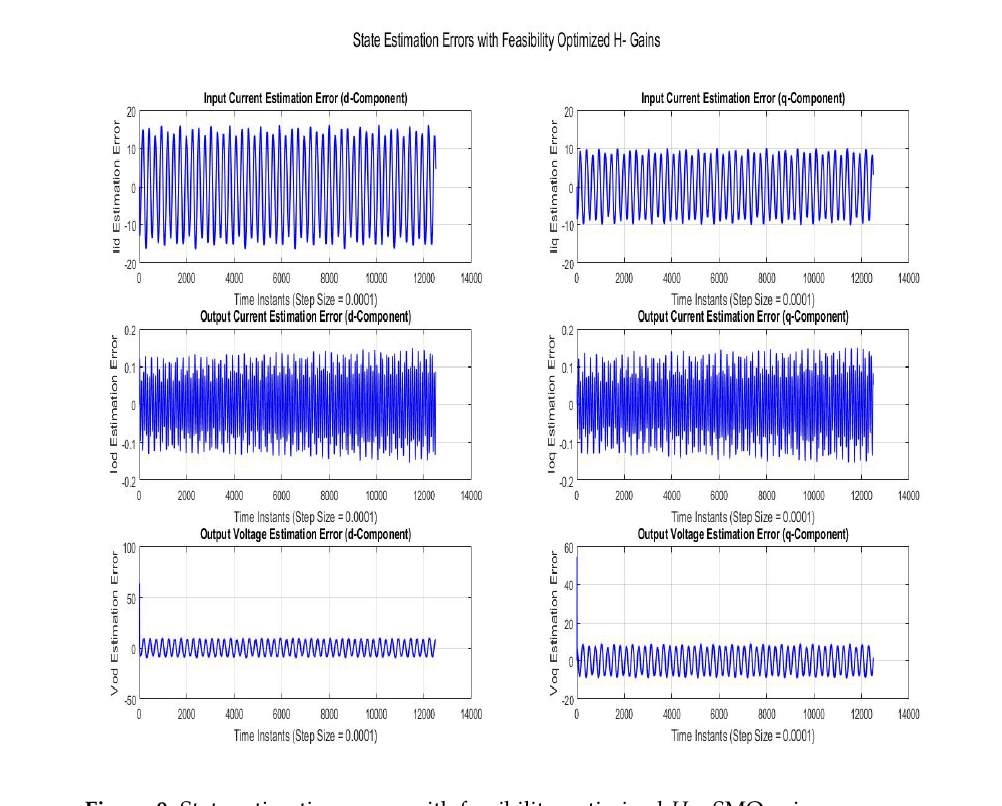
Figure 9. State estimation errors with feasibility optimized H − SMO gains.